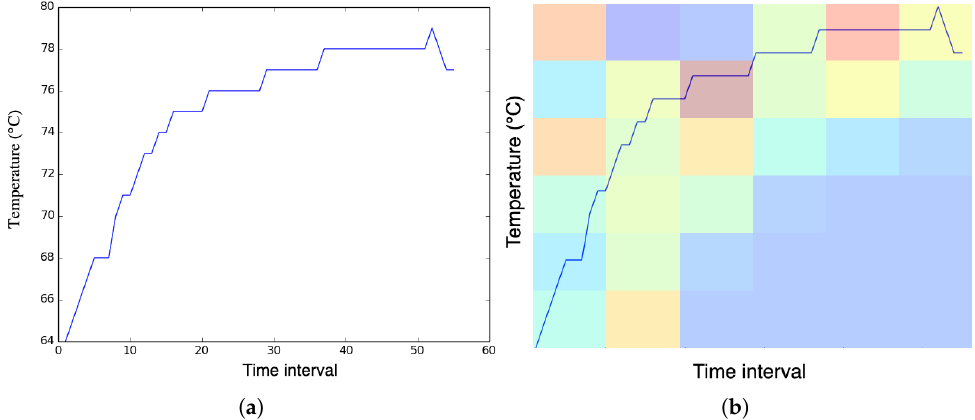
Figure 2. Focus area of ResNet50 network on a representative graph of password: